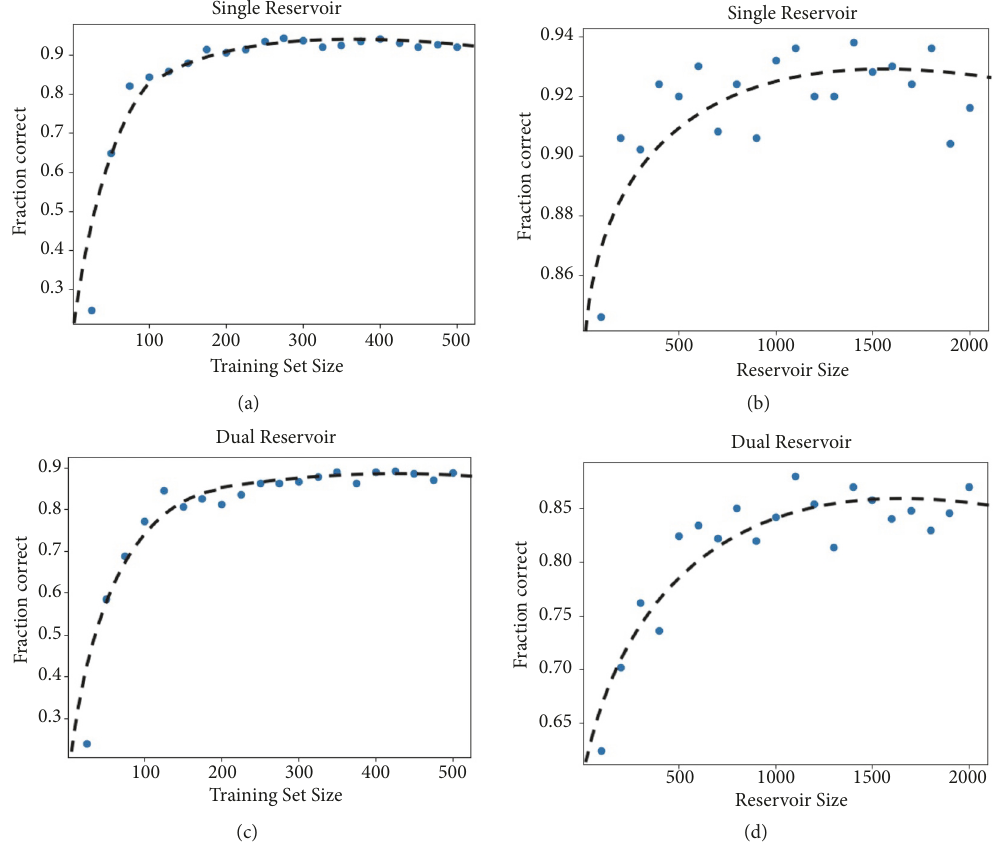
Figure 5: Fraction of image pairs correctly classified versus training set size (a and c) and reservoir size (b and d). Single reservoir results show in (a and b). Dual reservoir results shown in (c and d). Dashed curves denote fourth order polynomial best fit. Reservoir size=1000 nodes for (a and c); training size=250 pairs for (b and d). Spectral radius 𝛾 = 0.5 , sparsity = 0.9, and testing size= 500